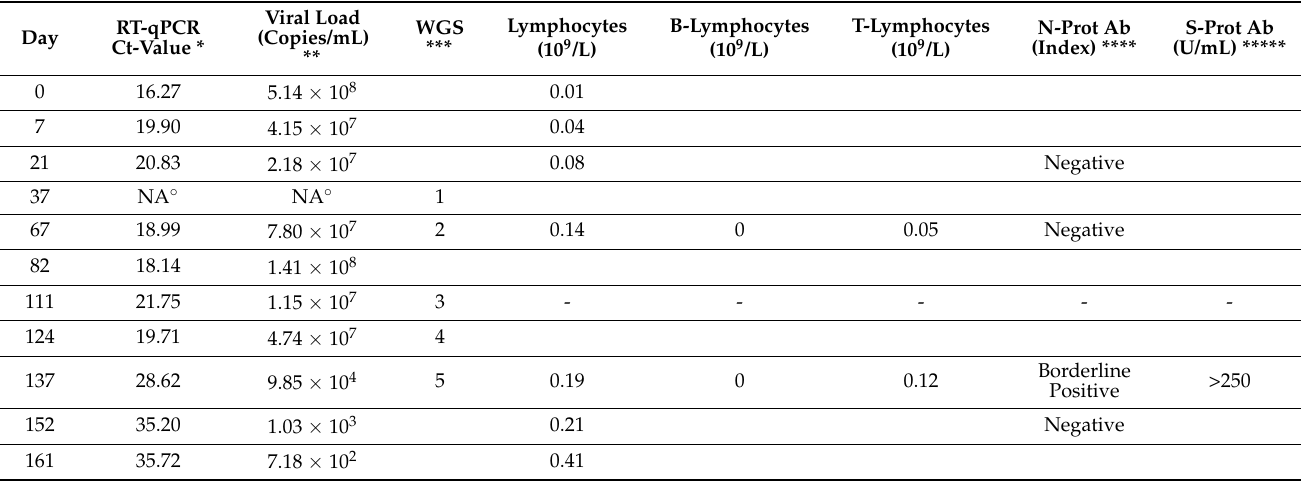
Table 1. Overview of the evolution of SARS-CoV-2 RT-qPCR Ct-values, haematology and SARS-CoV-2